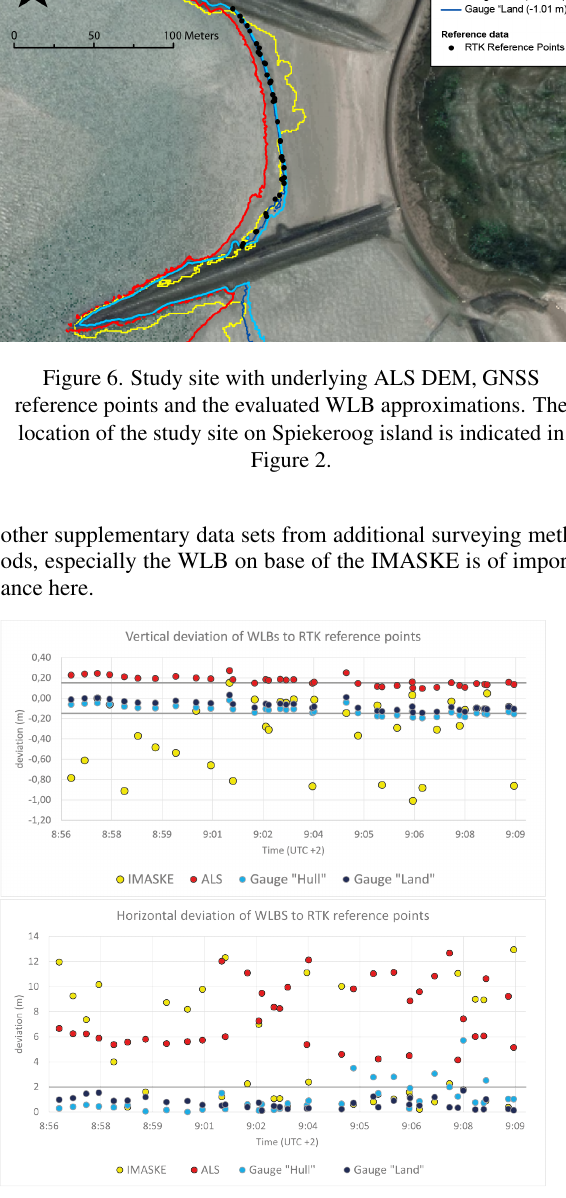
Table 1. Vertical and horizontal deviation (in m) of